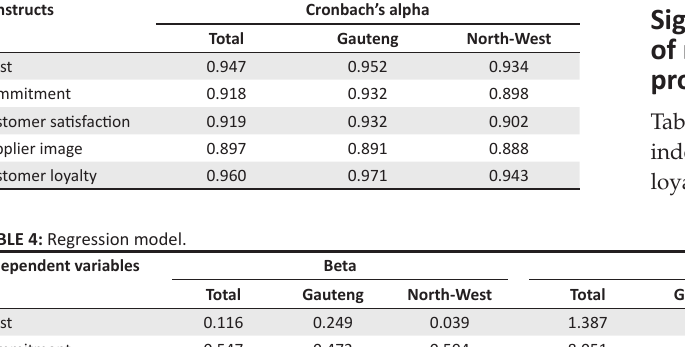
TABLE 3: Reliability statistics. Constructs